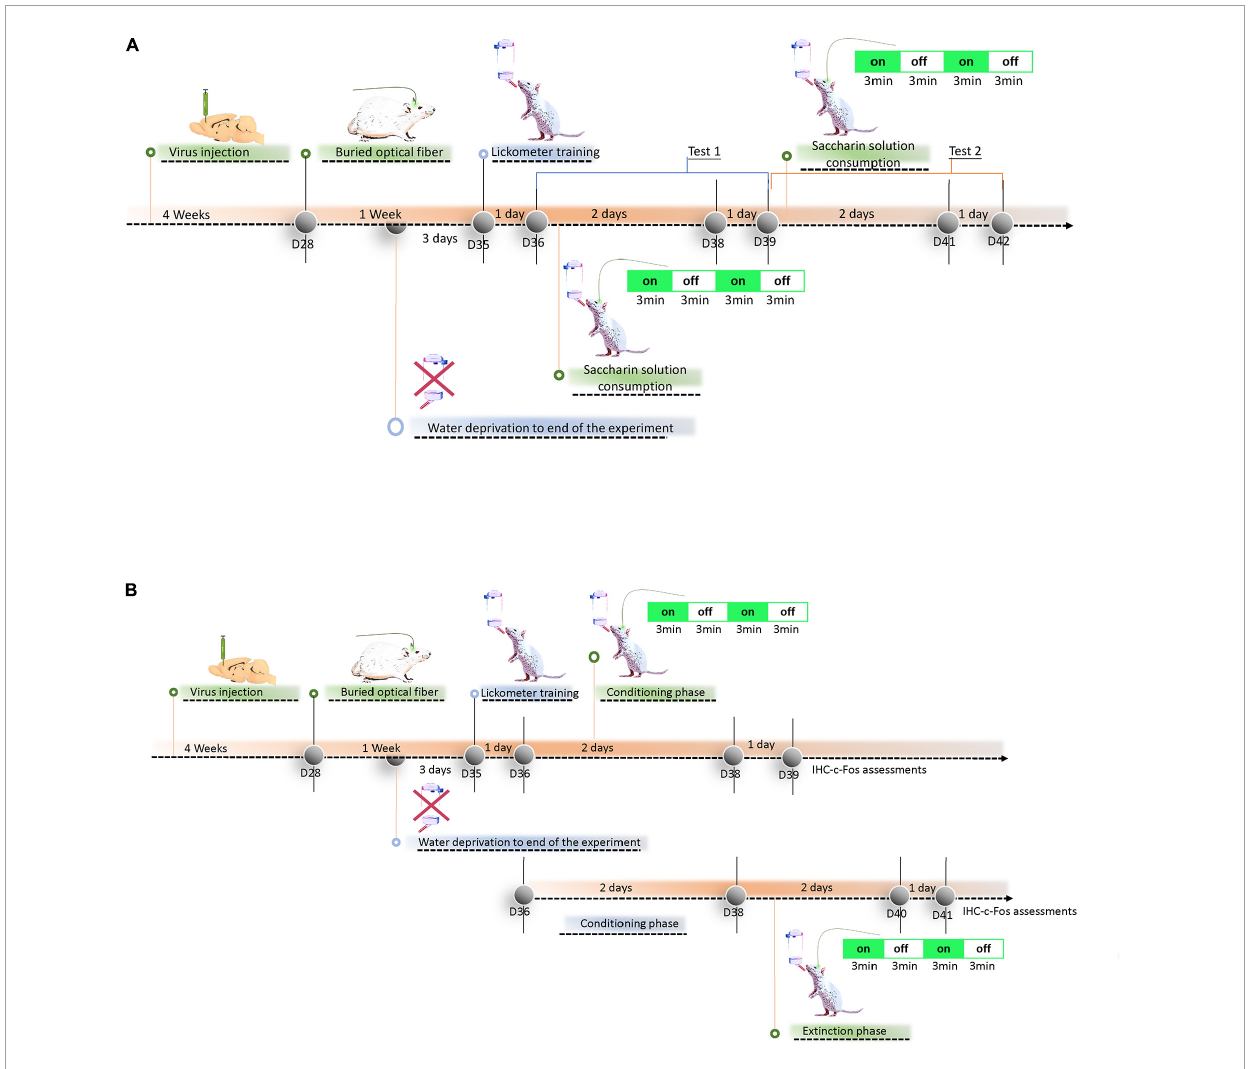
FIGURE1 Overview of experimental procedure. (A) Experiment 1: The experimental timeline included: virus injection and infection phase for 4 weeks, buried optical fiber and recovery from surgery for 1 week, water deprivation until the end of the experiment, lickometer drinking training for 1 day, 0.1% saccharin solution consumption with 3-min light-on and 3-min light-off treatment over 12 min for 2 days, and drinking 0.1% saccharin solution consumption with the light off over 12 min for 1 day in Test 1. The same cycle and experimental procedure were conducted for Test 2. (B) Experiment 2: The experimental timeline included: virus injection and infection phase for 4 weeks, buried optical fiber and recovery from surgery for 1 week, water deprivation to the end of the experiment, lickometer drinking training for 1 day, 0.1% saccharin solution consumption and conditioning with morphine for 3-min light-on and 3-min light-off treatment over 12 min for 2 days, and 0.1% saccharin solution consumption with light off over 12 min for 1 day. After virus injection, buried optical fiber, and lickometer drinking water for 1 day, the other rats received 0.1% saccharin solution conditioned with morphine injections for 2 days in the conditioning phase. Then, the rats were given the 0.1% saccharin solution without morphine injection in the extinction phase. In the extinction phase, 3-min light-on and 3-min light-off treatment was performed over 12 min.